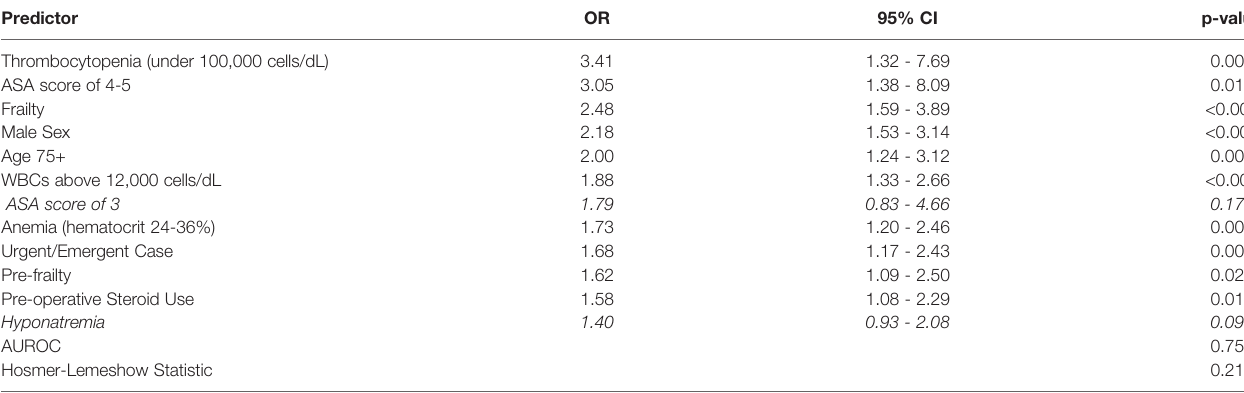
TABLE 5 | Multivariate logistic regression predictive model for 30-day death sorted by predictor effect size. Predictor OR 95% CI Thrombocytopenia (under 100,000